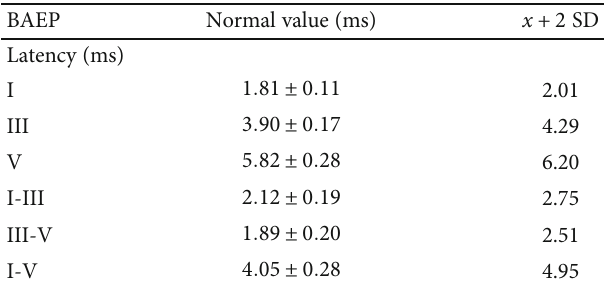
Table 1: Normative parameters for BAEP and x + 2 SD. SD: standard